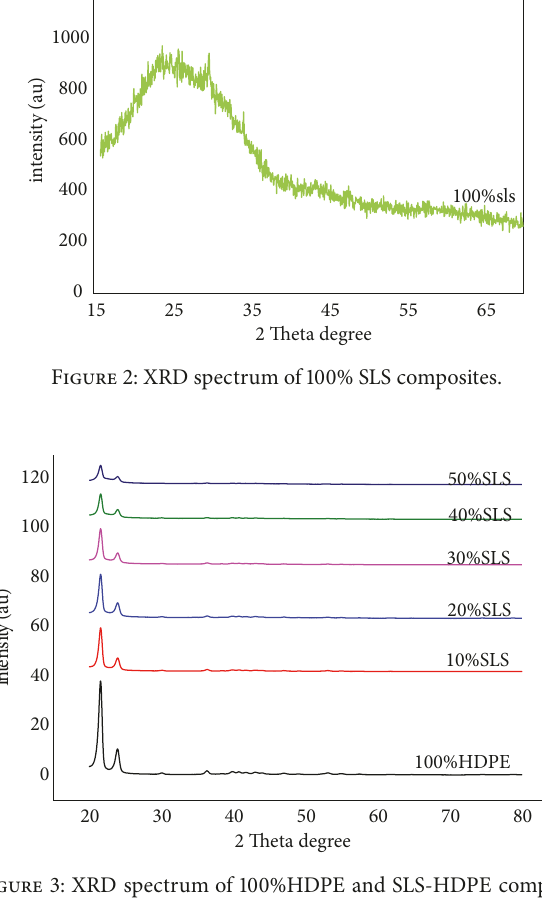
Figure 5: Variation in loss factor of SLS-HDPE composites. Table 2: Mean complex permittivity for all composites.